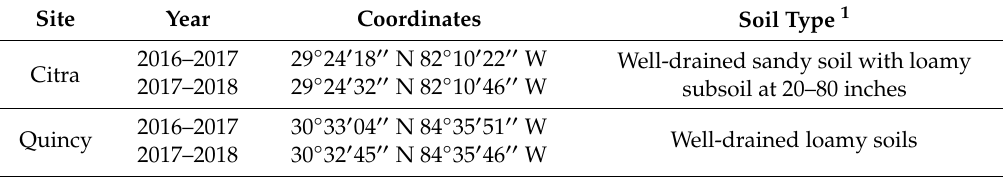
Table 1. Experimental site information including name of the sites, years evaluated, coordinates, and soil